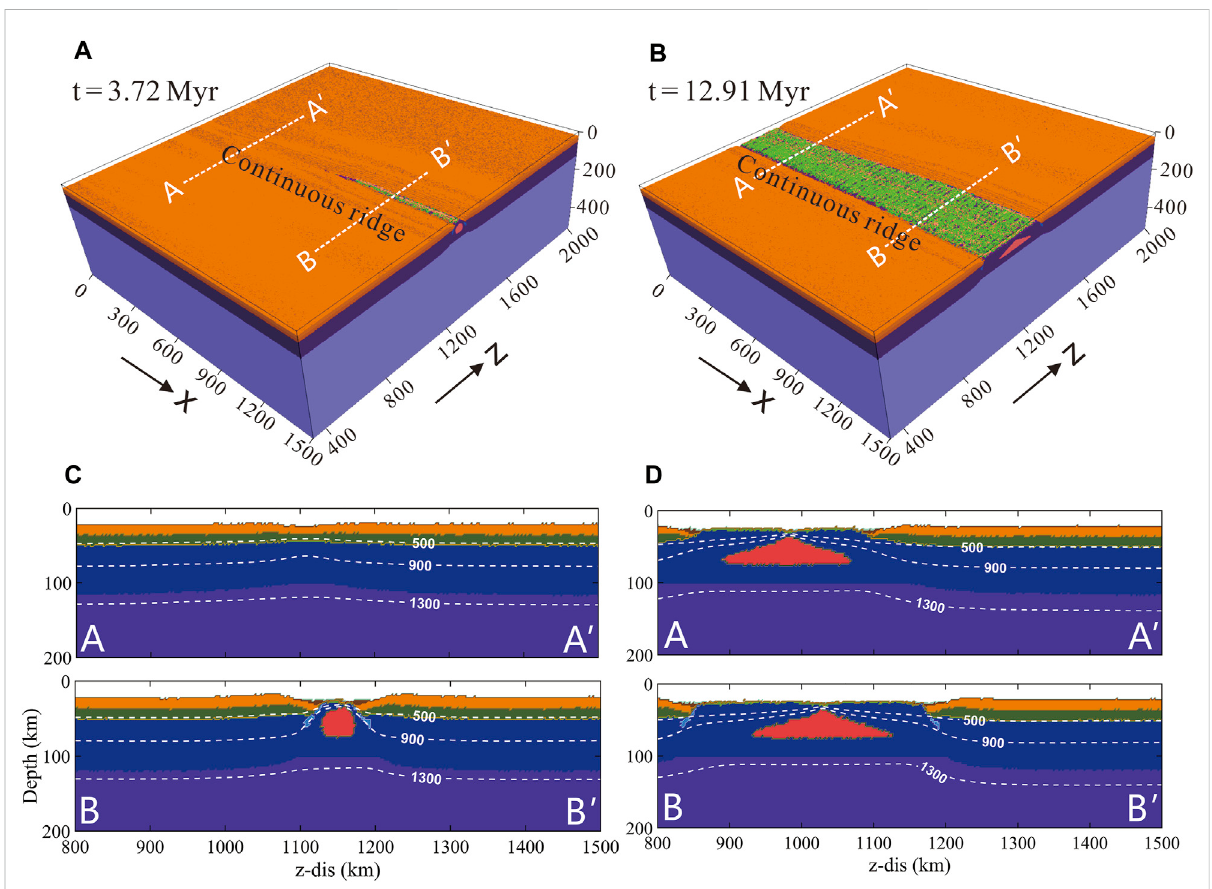
FIGURE 5 Evolutionoftheblankmodel(i.e.,withoutpre-existingtransformfaults)shownbylithology (A – B) Modelresultsin3Dviews (C – D) Modelresults shown in cross